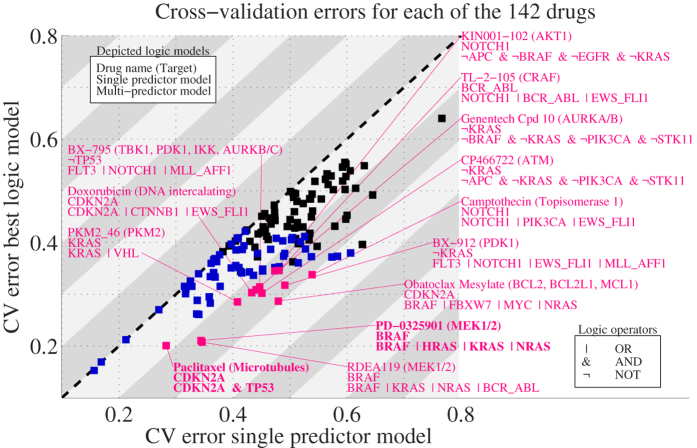
Multi-predictor models outperform single predictor models.Scatter plot with the 10-fold cross-validation (CV) error for single predictor models (x-axis) and the best (lowest CV error) multi-predictor model (y-axis). Each point represents one of the 142 drugs. Statistically significant models are highlighted in blue. Multi-predictor models that have a CV error lower than 0.35 and at least a 25% improvement upon the single predictor model are highlighted in magenta. The two examples discussed in the text are highlighted in bold typeface.